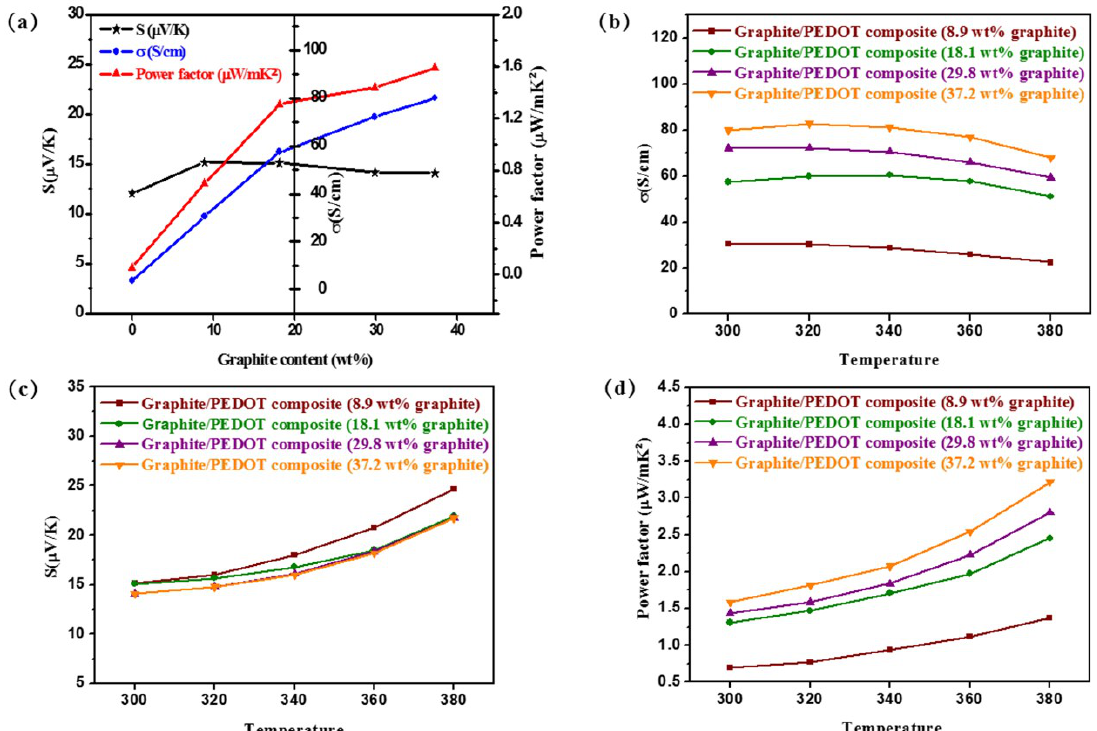
Figure 4. ( a ) electrical conductivity, Seebeck coefficient, and power factor of graphite/PEDOT nanocomposites with different content of graphite from 0 to 37.2 wt % at 300 K. Temperature dependency of ( b ) electrical conductivity, ( c ) Seebeck coefficient, and ( d ) power factor of graphite/PEDOT nanocomposites with different content of graphite from 8.9 to 37.2 wt %.